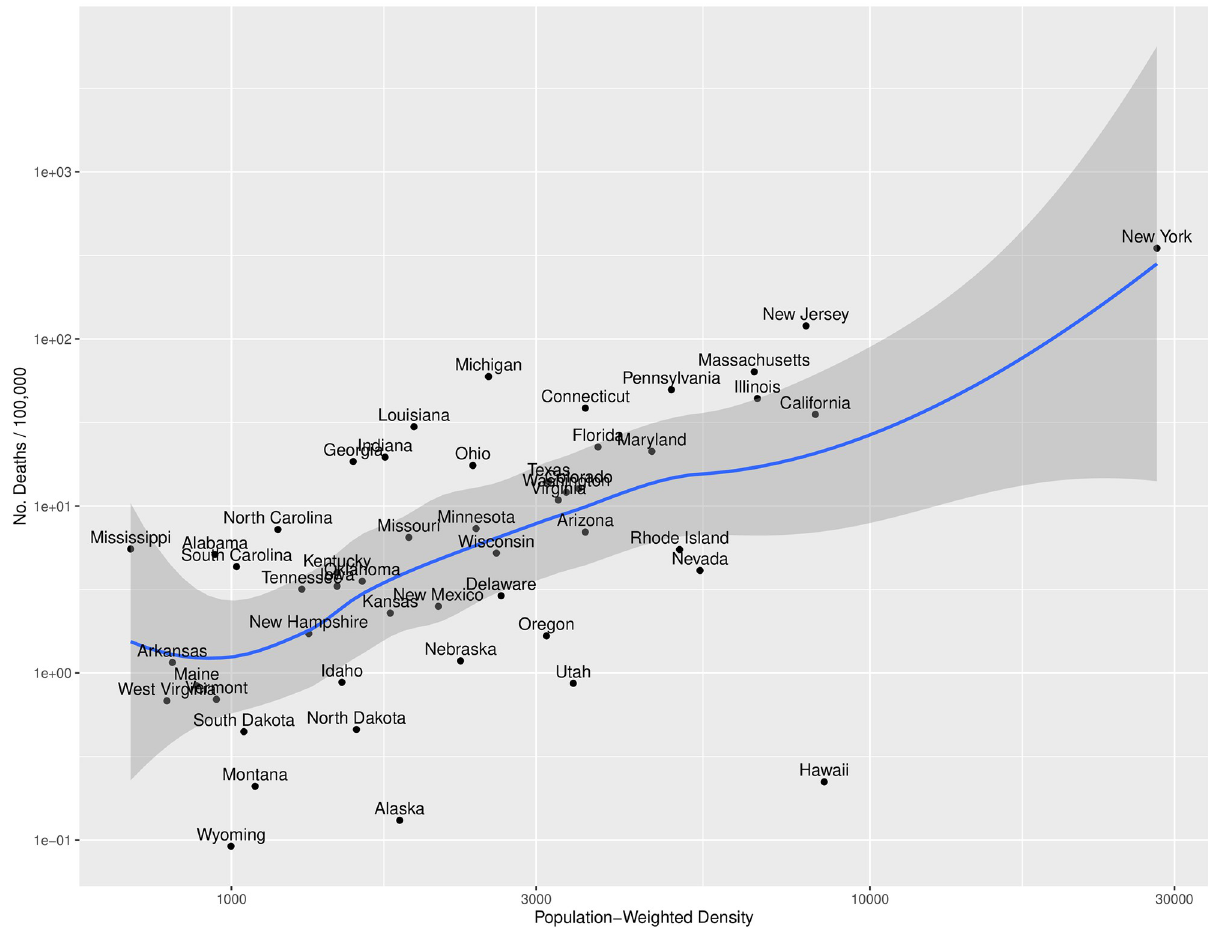
Fig 2. The relationship between the number of deaths per 100,000 and PWPD. Each state is identified with a dot and the variability and smooth profile are shown with the dark grey region and blue line,